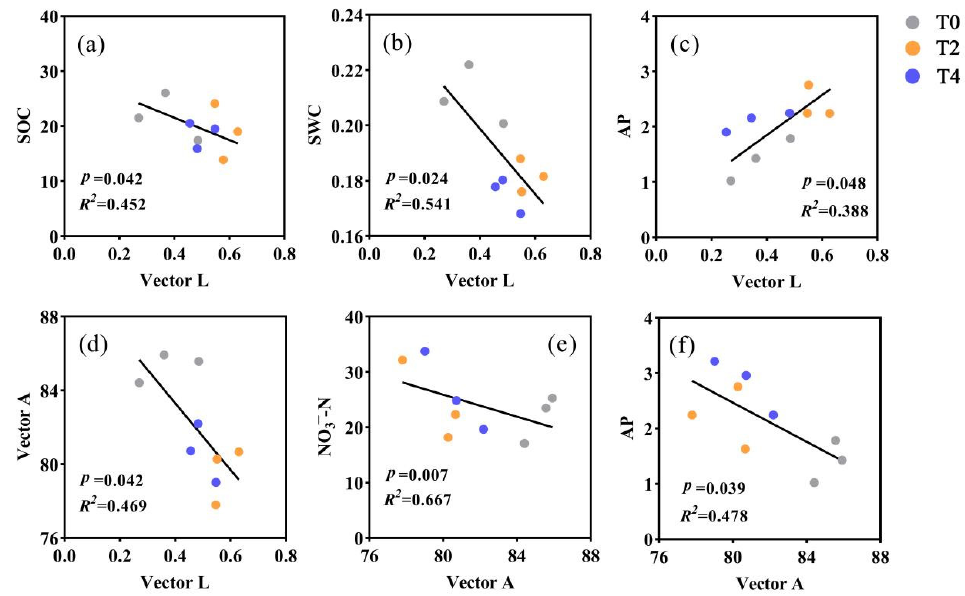
Figure 3. Relationships between microbial C limitation with SOC ( a ), SWC ( b ), AP ( c ), and microbial P limitation ( d ). Relationships between microbial P limitation with NO 3 − -N ( e ), AP ( f ). T0: control without warming; T2: 2 °C warming treatment; T4: 4 °C warming treatment.